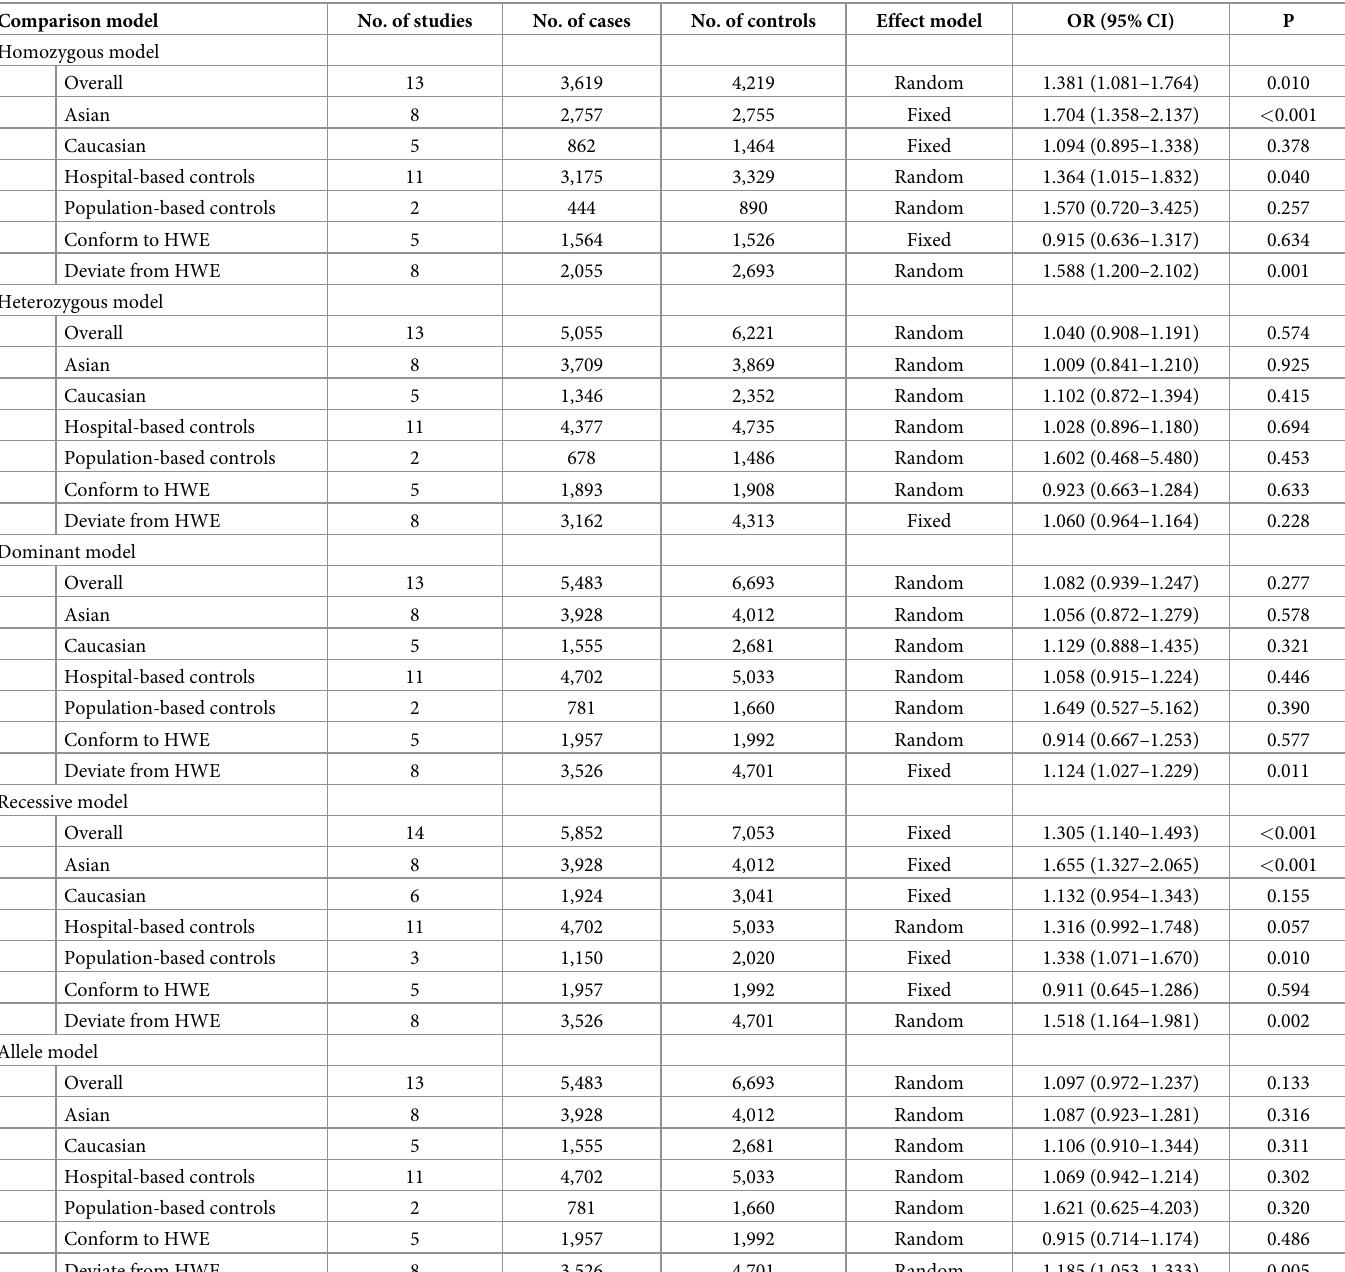
Table 2. Summary of the association between XRCC3 p.Thr241Met polymorphism and glioma risk. Comparison